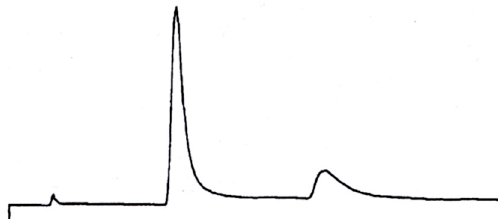
Figure 17. HPLC separation of C 60 (12.2 min) and C 70 (23.5 min) on a Pirkle-type ionically DNBPG containing column (250 × 10 mm I.D.) eluted with n -hexane at 5.0 mL/min and detected at 280 nm, α